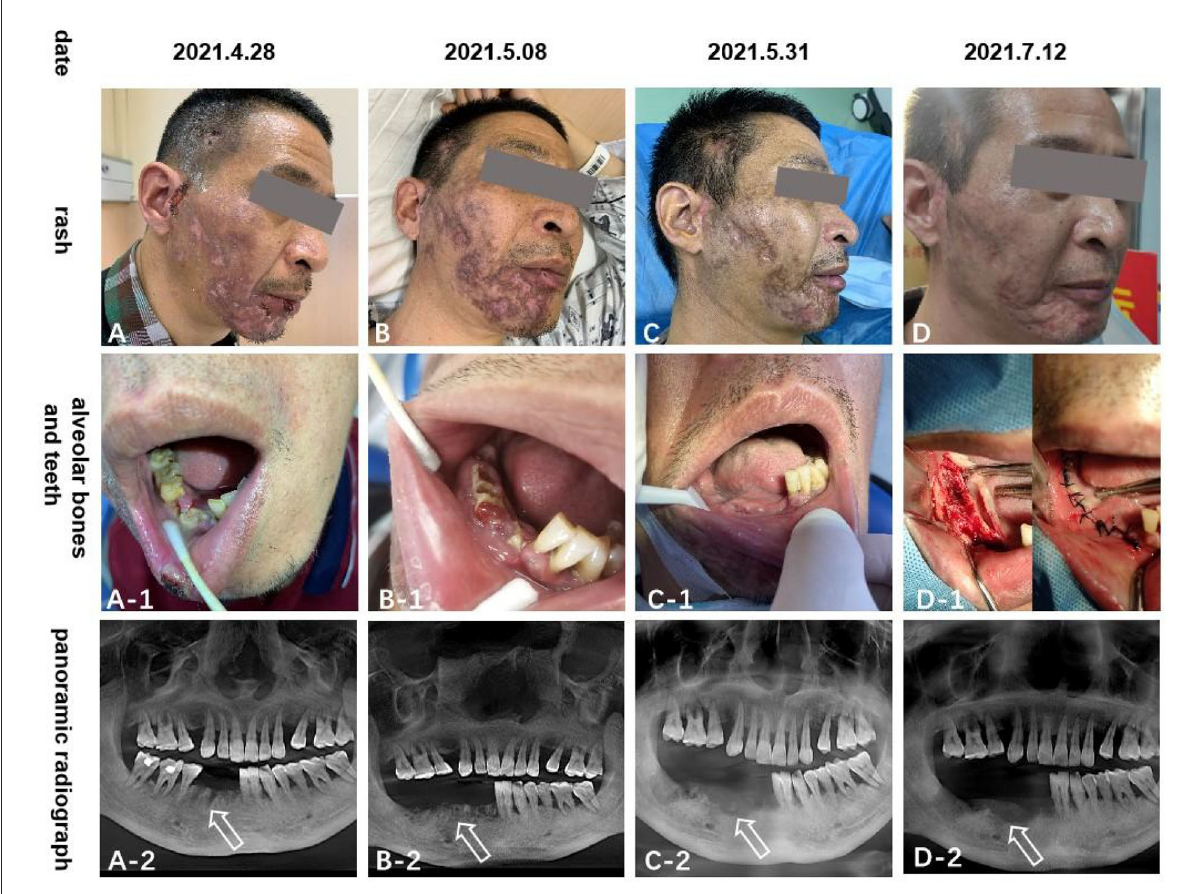
FIGURE2 The (A–D) pictures show the rash scar gradually becomes shallow; (A-1–D-1 ) and (A-2–D-2) pictures show that the right mandibular teeth gradually fall off and the alveolar bone gradually